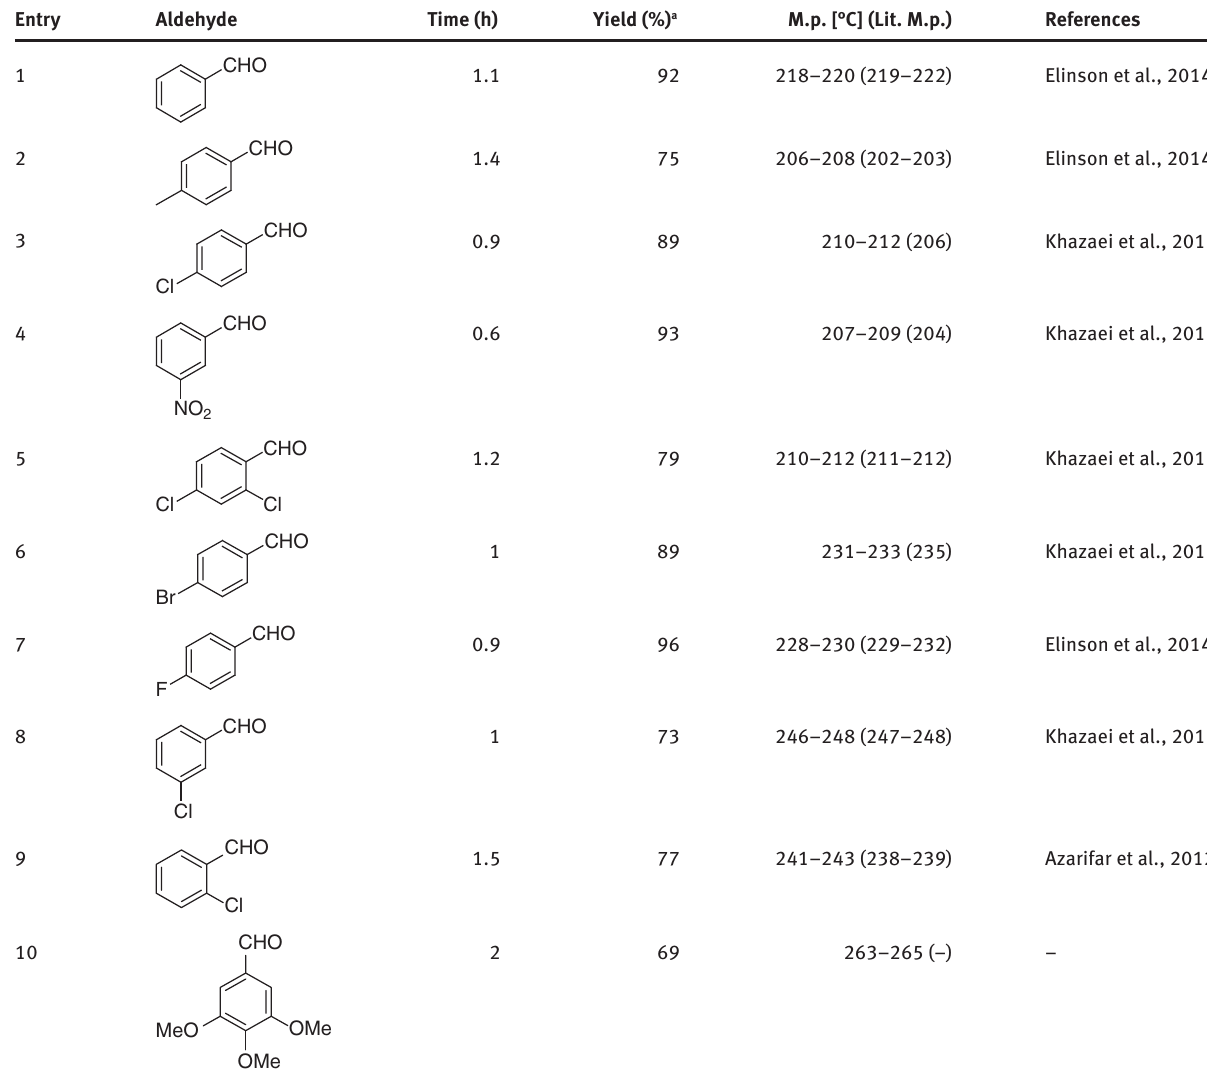
Table 2: Preparation of pyrano[2,3-d]pyrimidines using nano-basic silica as catalyst (25